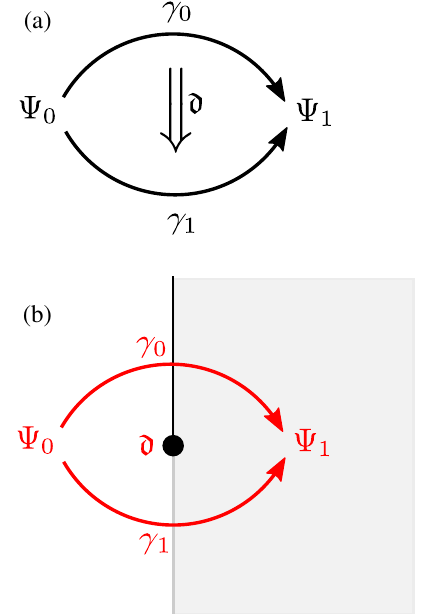
FIG. 8. (a) Specifying the homotopy type of the space Θ of all TQFTs involves specifying points in this space, paths between arrows (single arrows), deformations between paths (double arrow), and so on. We want these to capture features of the space of quantum ground states. (b) These features can also be interpreted as interfaces. We show a spatial configuration of interfaces in a two-dimensional system, with two one- dimensional interfaces separated by a junction of dimension 0. We can imagine that these interfaces are smoothed out such that the spatial variation occurs on scales that are large compared to the lattice spacing (thus, we have a smooth state as discussed in Secs. II and III B). Traversing a path in R 2 from the left half-plane to the right half-plane, the local quantum state goes through the path γ 0 or γ 1 depending on whether the path in R 2 goes through the upper one-dimensional interface or the lower one. As one deforms the path in R 2 through the zero-dimensional junction (black dot), the corresponding path in the space of quantum states goes through the deformation described by d